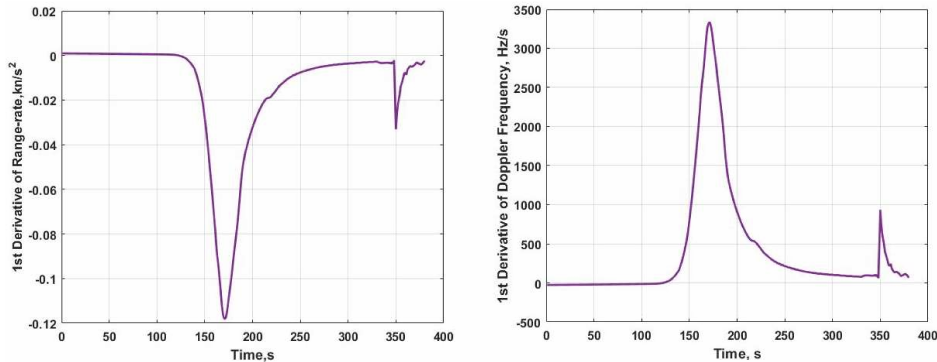
Figure 4. Computed first-order derivative values of Doppler for MSL: ( a ) First-order derivatives of range rate; ( b ) Doppler rate (X-band).